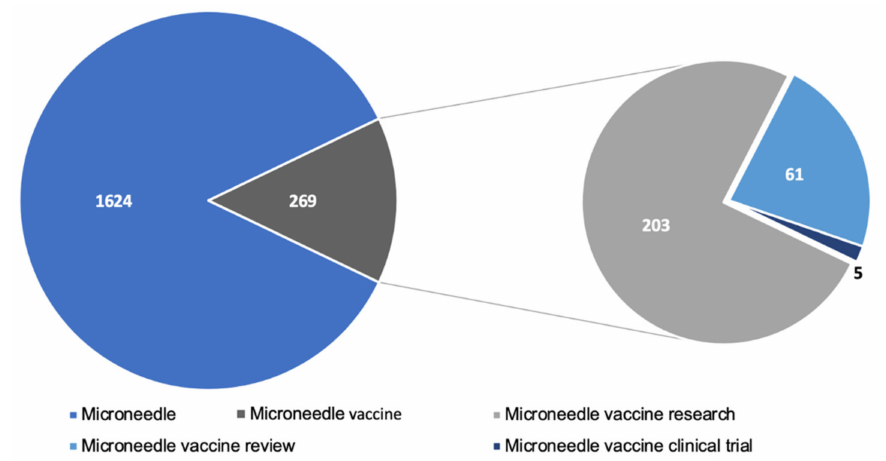
Figure 5. Microneedle related literature published in PubMed since